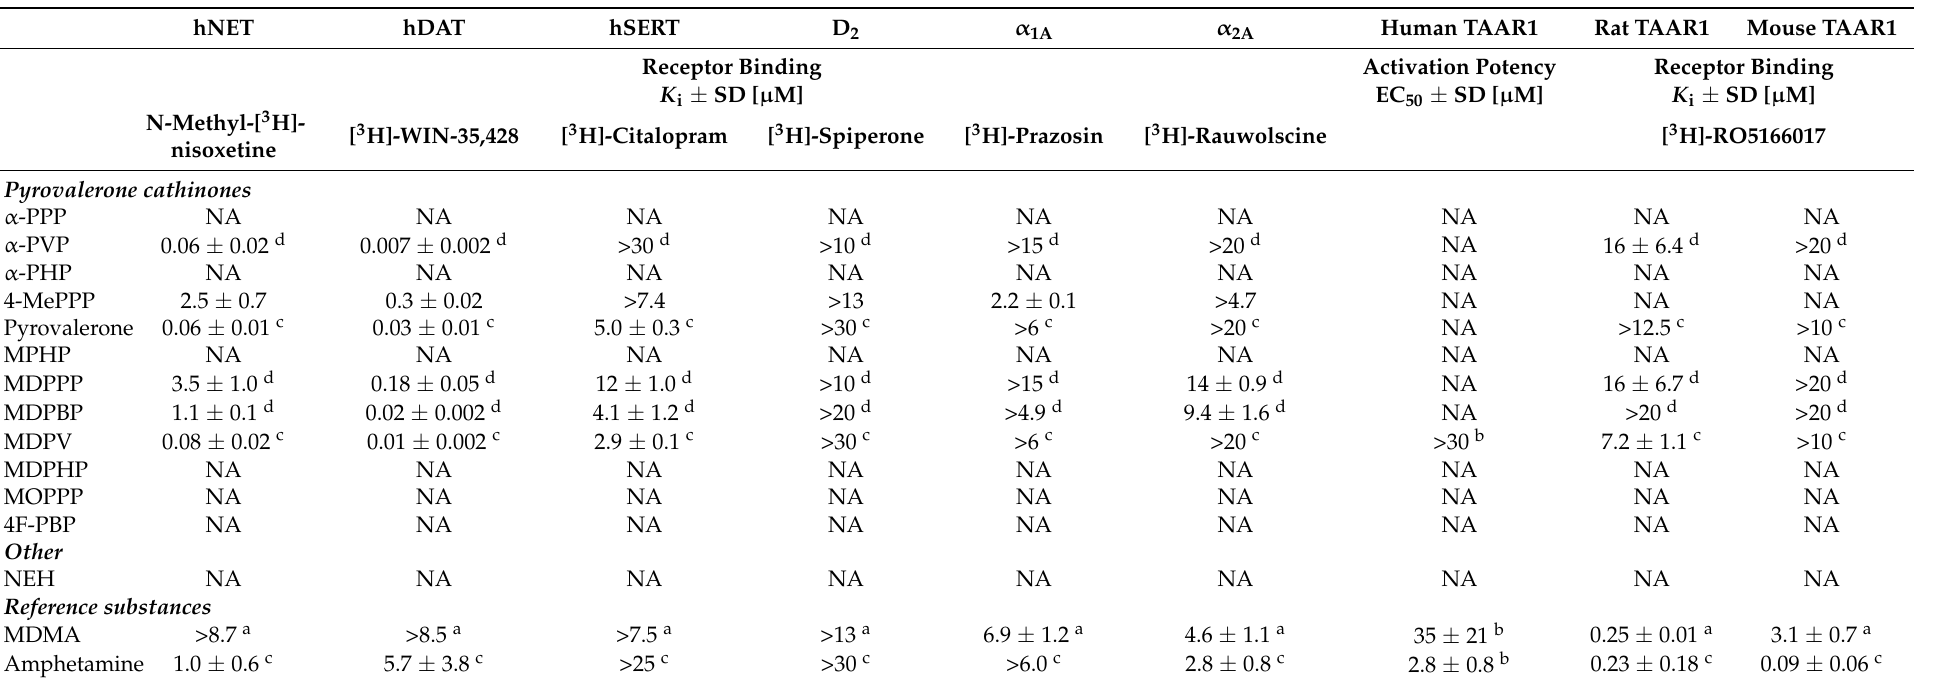
Table 3. Monoamine transporter and receptor binding affinities of pyrovalerone and